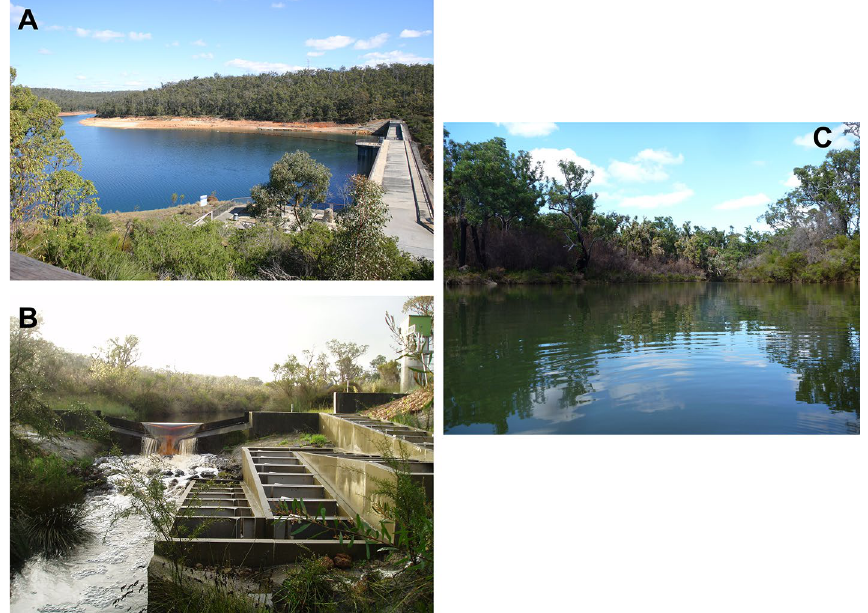
Figure 4. ( A ) Victoria Reservoir, Canning River, near Perth, Western Australia, type locality for W. carteri . Photo by Corey Whisson. ( B ) Goodga River, Western Australia, type locality for W. inbisi inbisi , at vertical slot fishway where holotype of W. inbisi inbisi was collected from. Photo provided with permission by Dr Stephen J. Beatty. ( C ) Margaret River, Western Australia, type locality for W. inbisi meridiemus , at Canebreak Pool. Photo by Dr Michael W. Klunzinger.